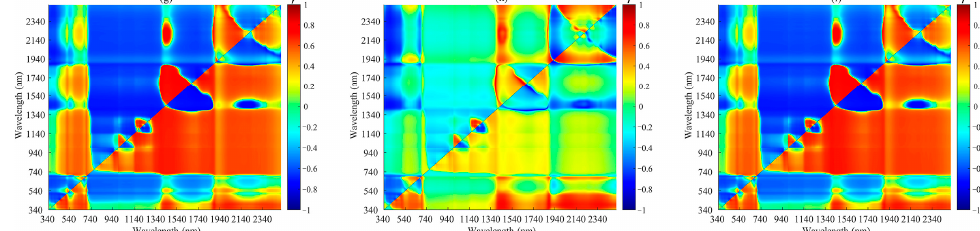
Figure 6. Coefficients of correlation between EWT, RWC, and LFMC with RVI ( λ 1, λ 2), NDVI ( λ 1, λ 2), DVI ( λ 1, λ 2), and ratio/normalized difference/difference vegetation indexes constructed from raw spectral data. ( a ) Correlation between EWT and RVI (RVI band combinations based on raw reflectance relationship with EWT); ( b ) Correlation between EWT and DVI; ( c ) Correlation between EWT and NDVI; ( d ) Correlation between RWC and RVI; ( e ) Correlation between RWC and DVI; ( f ) Correlation between RWC and NDVI; ( g ) Correlation between LFMC and RVI; ( h ) Correlation between LFMC and DVI and ( i ) Correlation between LFMC and NDVI.